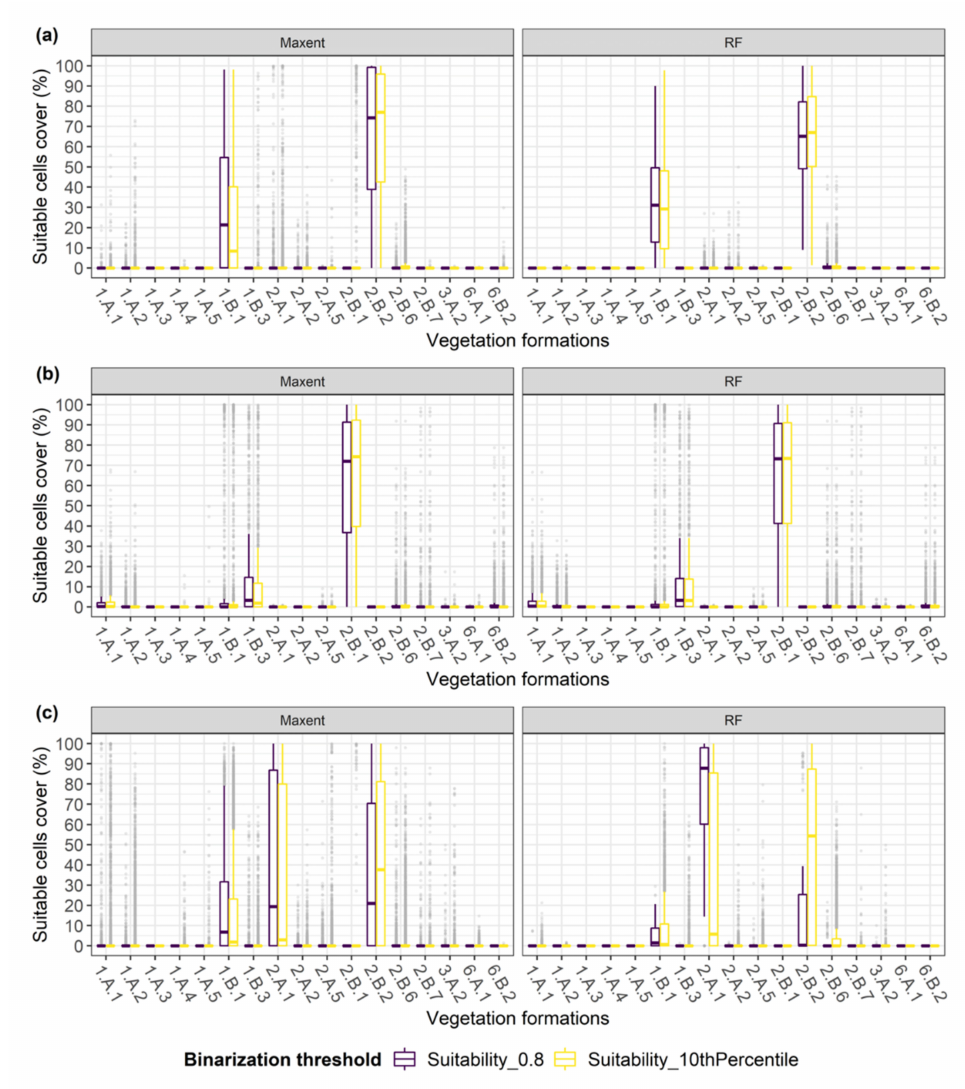
Figure 8. Percentage coverage by each of the 17 vegetation formations (see Table 1) of the pix- els predicted as climatically suitable after binarizing the Maxent-derived (left) and RF-derived (right) weighted average predictions through either the 10th percentile training threshold or the HS ≥ 0.8 threshold, for: ( a ) Chaetocnema brincki ; ( b ) C. danielssoni ; ( c ) C. gahani . Mediterranean Scrub and Grassland (2.B.1) was the predominant vegetation formation within climatically suitable areas individuated for C. darwini , with a median percentage cover ranging from 25% for the Maxent × 10th percentile combination to 70% for the RF × HS ≥ 0.8 one (Figure 9a); considering the 10th percentile training threshold, Tropical Seasonally Dry Forest (1.A.1) emerged as the formation with the second highest percent- age cover of suitable pixels for this species, particularly in Maxent-derived binarized predictions. For C. natalensis , the percentage cover of climatically suitable pixels by the different vegetation formations varied noticeably with the chosen binarization threshold (Figure 9b): suitable areas individuated through the 10th percentile training threshold appeared to be primarily covered by Temperate Grassland, and Meadow and Shrubland (2.B.2), followed by Warm Temperate Forest (1.B.1), and Tropical Lowland Grassland, and Savanna and Shrubland (2.A.1); differently, pixels predicted as being suitable using the HS ≥ 0.8 threshold, primarily confined to the southern coastal region, were mainly covered by Tropical Seasonally Dry Forest (1.A.1) and Tropical Lowland Humid Forest (1.A.2) with median coverage values around